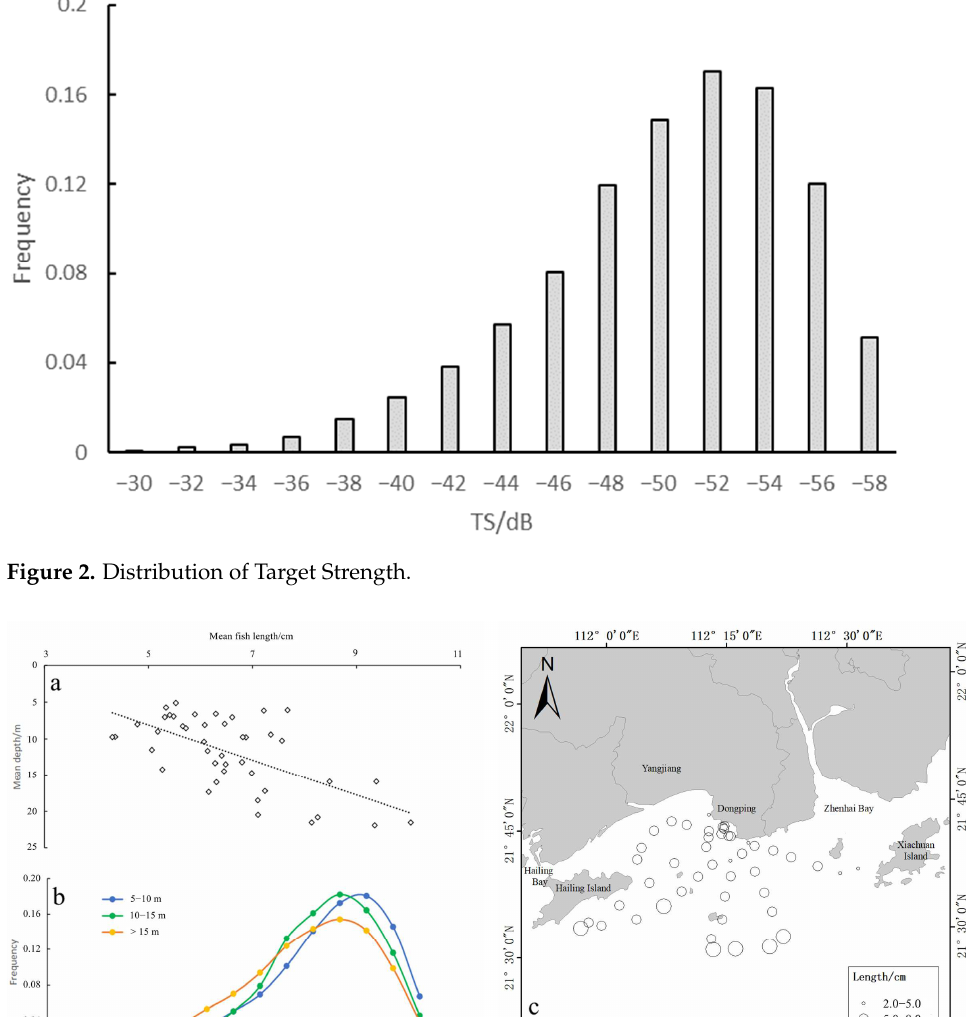
Figure 3. ( a ) Relationship between mean fish length and mean depth. ( b ) TS distribution in different water depth. ( c ) Spatial distribution of mean fish length in Yangjiang coastal waters